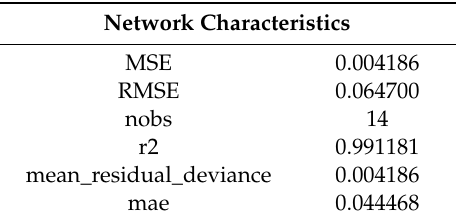
Figure 1. Screenshot of the learning process in H 2 O. Table 5. Network characteristics.